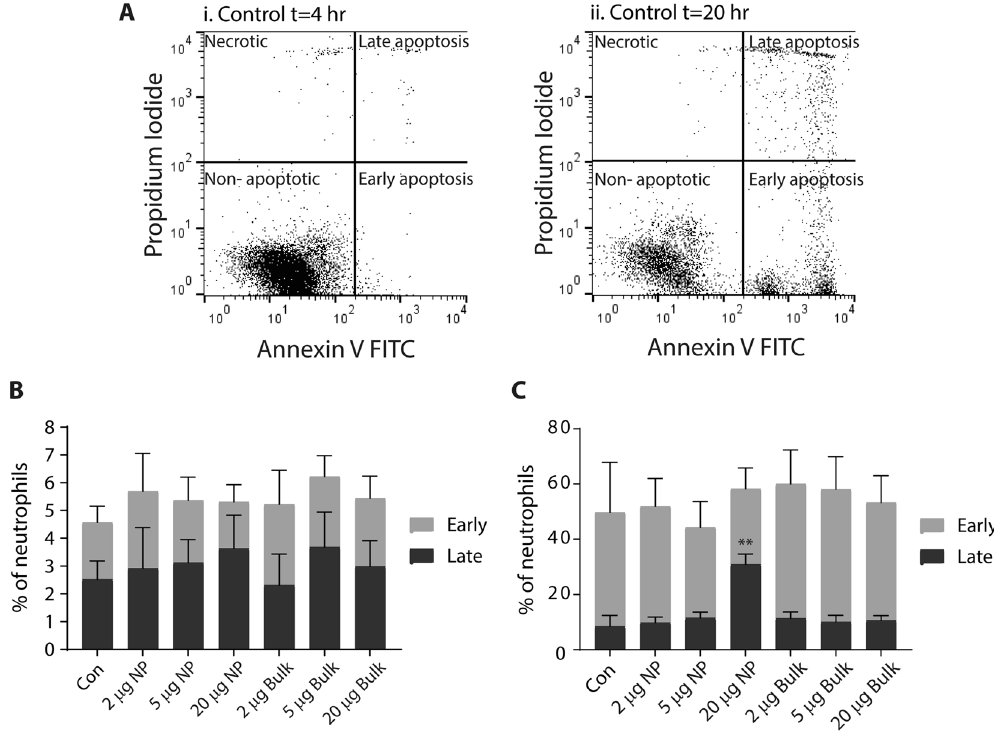
Figure 2. The impact of silver nanoparticles on human neutrophil viability. ( A ) Representative dot plots obtained from AnnexinV-FITC/Propidium iodide staining of neutrophil viability after T = 4 hr (panel i) and 20 hr (panel ii) in culture. The position of the quadrants and the type of cell death depicted in each quadrant is indicated. ( B and C ) Human neutrophils were untreated (Con) or exposed to 2, 5 or 20 µ g AgNP (NP) or Ag Bulk particles per 10 5 cells for 4 hr and 20 hr at 37 °C before viability was assessed via AnV and PI staining and flow cytometry, counting 10000 gated events. The number of events per quadrant was calculated as a percentage of total number of gated events and expressed as the percentage of early (AnV + ve /PI − ve ) or late (AnV + ve /PI + ve ) stage apoptosis at either 4 hr ( B ) and 20 hr ( C ); Data is presented as the mean percentage ± SEM where n = 3–4; ** p <